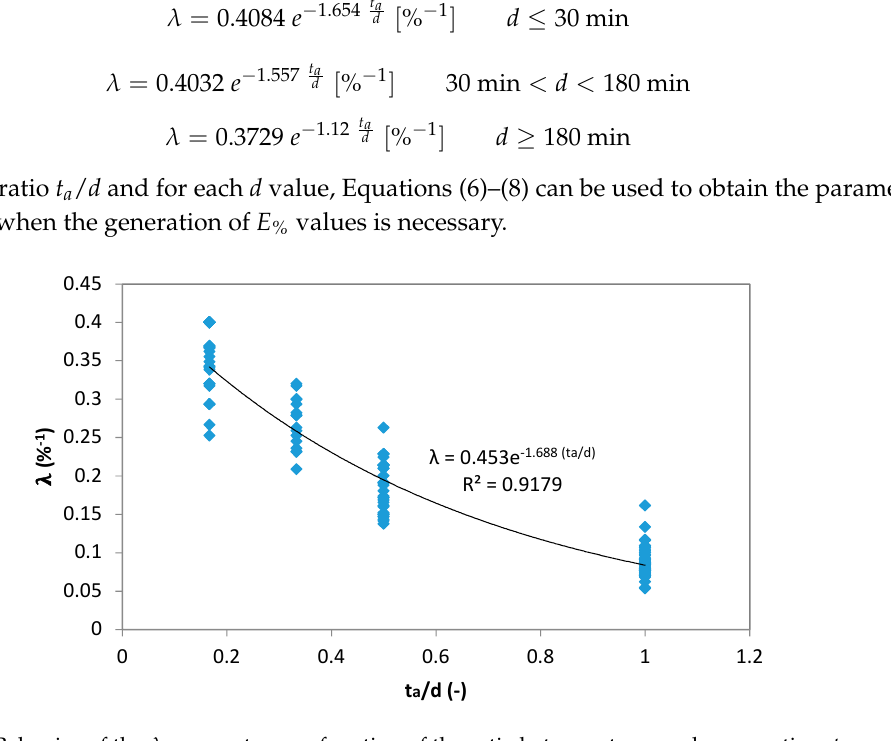
Figure 8. Behavior of the λ parameter obtained by Equations (6)–(8) depending on ratio t a / d where t a is the time resolution of rainfall data and d is the duration. 4.2. Average Error Analysis The main characteristics of the average underestimation error of annual maximum rainfall depth, E a% , were analyzed by Reference [25]. They concluded that, in the worst conditions that occur for t a = d , the E a% for a series of appropriate length is less than or equal to 16.67% and developed reliable relationships between E a% and values of t a and d . In this work, as an element of novelty, the analysis of the statistical distribution of the average error was carried out. Additionally, for the average underestimation error, the relative frequency was evaluated by considering different t a / d ratios and adequate classes’ amplitudes. From the visual analysis of Figure 9 and, from the adoption of the main statistical tests (Pearson, Kolmogorov ‐ Smirnov, Anderson ‐ Darling), it may be deduced that the following normal distribution function correctly represents the behavior of the random variable. (cid:1858)(cid:4666)(cid:1831) (cid:3028)% (cid:4667) (cid:3404) 1 √2(cid:2024)(cid:2026) (cid:2870) (cid:1857) (cid:2879)(cid:4666)(cid:3006) (cid:3276)% (cid:2879)(cid:3091)(cid:4667) (cid:3118) (cid:2870)(cid:3097) (cid:3118) (9) where μ and σ are the sample expected value and standard deviation, respectively. For the μ parameter, results relevant to Morbidelli et al. (2017) were obtained. In fact, in this case, the results showed that the μ parameter depends on both the t a / d ratio and d. Specifically, for t a / d = 1 values of μ = 12.40%, 11.89%, and 10.41% were found for d = 30 min, 60 min, and 1440 min,